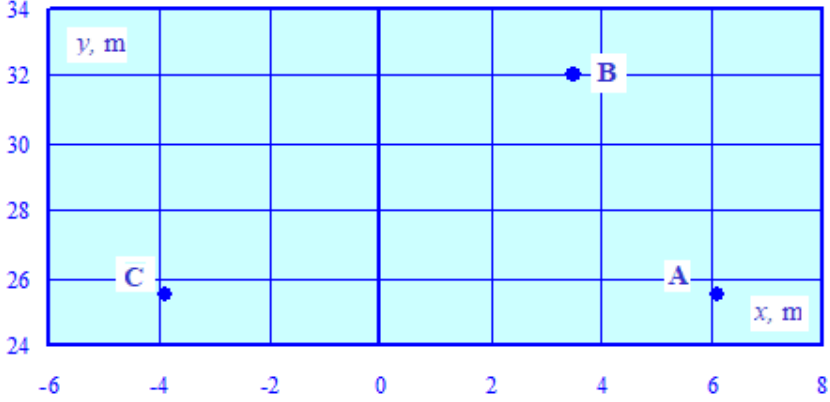
Figure 1. Network circuit: TS–traction substation.